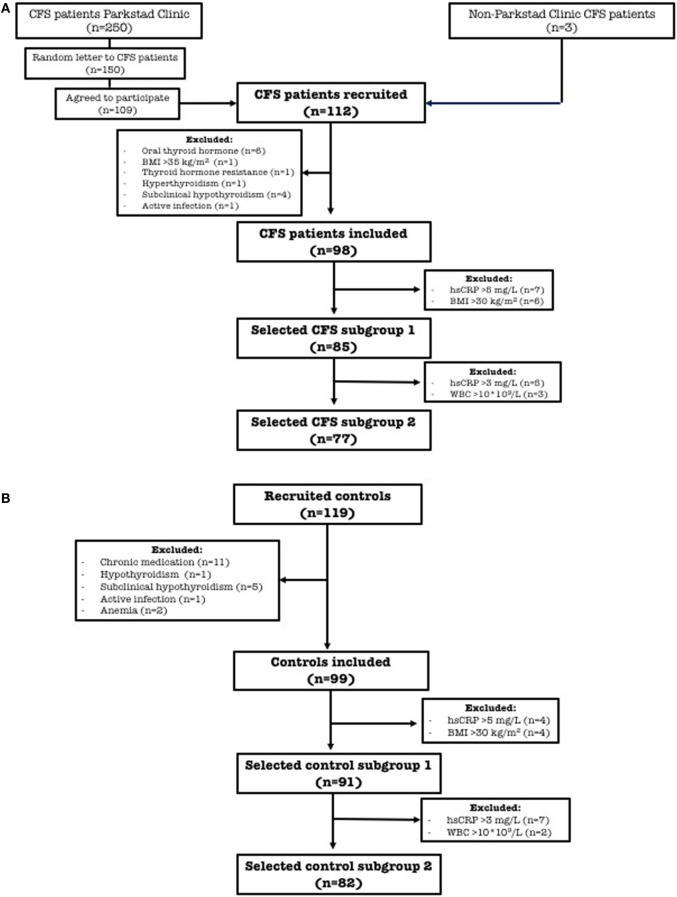
Flow-chart: inclusion of chronic fatigue syndrome patients (A) and controls (B) in the different groups and subgroups. Abbreviations: CFS, chronic fatigue syndrome; n, number of subjects; BMI, body mass index; hsCRP, high-sensitive C-reactive protein; WBC, white blood cells.